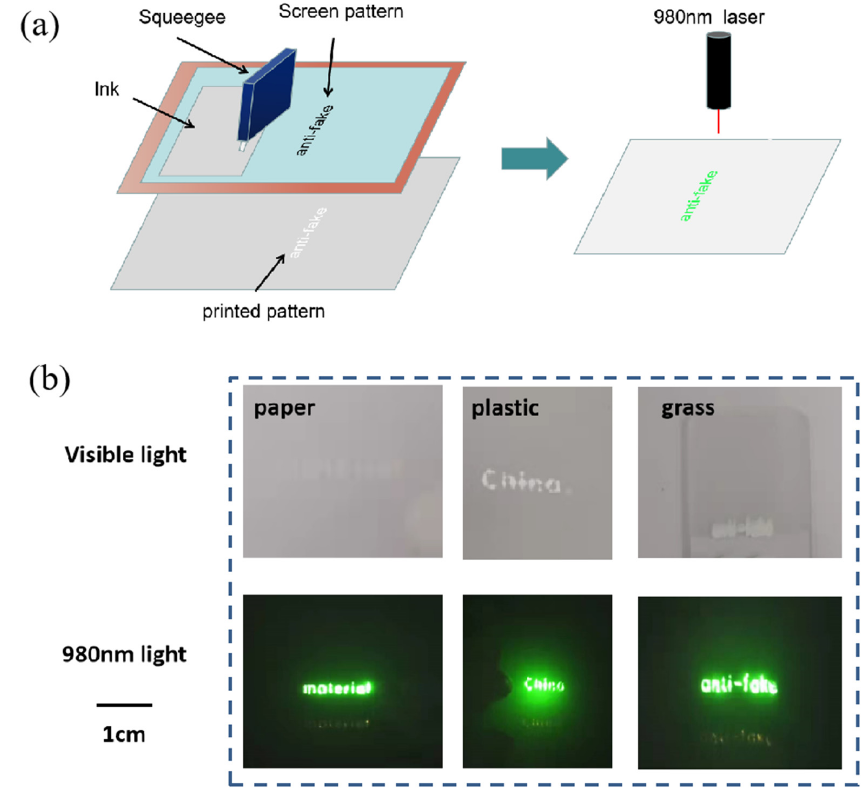
Figure 7. ( a ) Demonstration of the screen-printing process and the anti-counterfeiting application of 980 nm excitation. ( b ) Photographs of different kinds of anti-counterfeiting characters that were printed onto various materials with the composites as inks under the excitation of a 980 nm laser. Screen printings were made on various materials, including paper, plastic sheet, and glass sheet. The photographs of the imaging experiments are shown in Figure 7b. All characters’ patterns on different materials were almost invisible under daylight condi- tions. However, the as-printed characters on various materials became green and clearly visible under the excitation of the 980 nm laser. This shows that the LiYF 4 :Yb 3+ /Ho 3+ UCMPs with different Mg 2+ ion doping have good application potential in an- ti-counterfeiting recognition. 4. Conclusions In summary, LiYF 4 :Yb 3+ /Ho 3+ UCMPs with different Mg 2+ ion doping concentrations were synthesized and investigated. The emission peaks of Ho 3+ ions were 480 nm, 535 nm, 543 nm, 638 nm, 657 nm, and 750 nm under the excitation of a 980 nm laser when different concentrations of Mg 2+ ions were incorporated. The photoluminescence inten- sity reached its maximum when the Mg 2+ ion doping concentration was 8 mol%. The prepared UCMPs were incorporated into a screen-printing agent. Characters were printed on different materials using the engraved screen-printing template. The printed characters were clearly visible under the irradiation of a 980 nm laser. The synthesized LiYF 4 :Yb 3+ /Ho 3+ /Mg 2+ UCMPs have potential application prospects in anti-counterfeiting recognition. Supplementary Materials: The following supporting information can be downloaded at: www.mdpi.com/xxx/s1, Table S1: ICP-OES results of LiYF4:Yb 3+ /Ho 3+ /Mg 2+ .